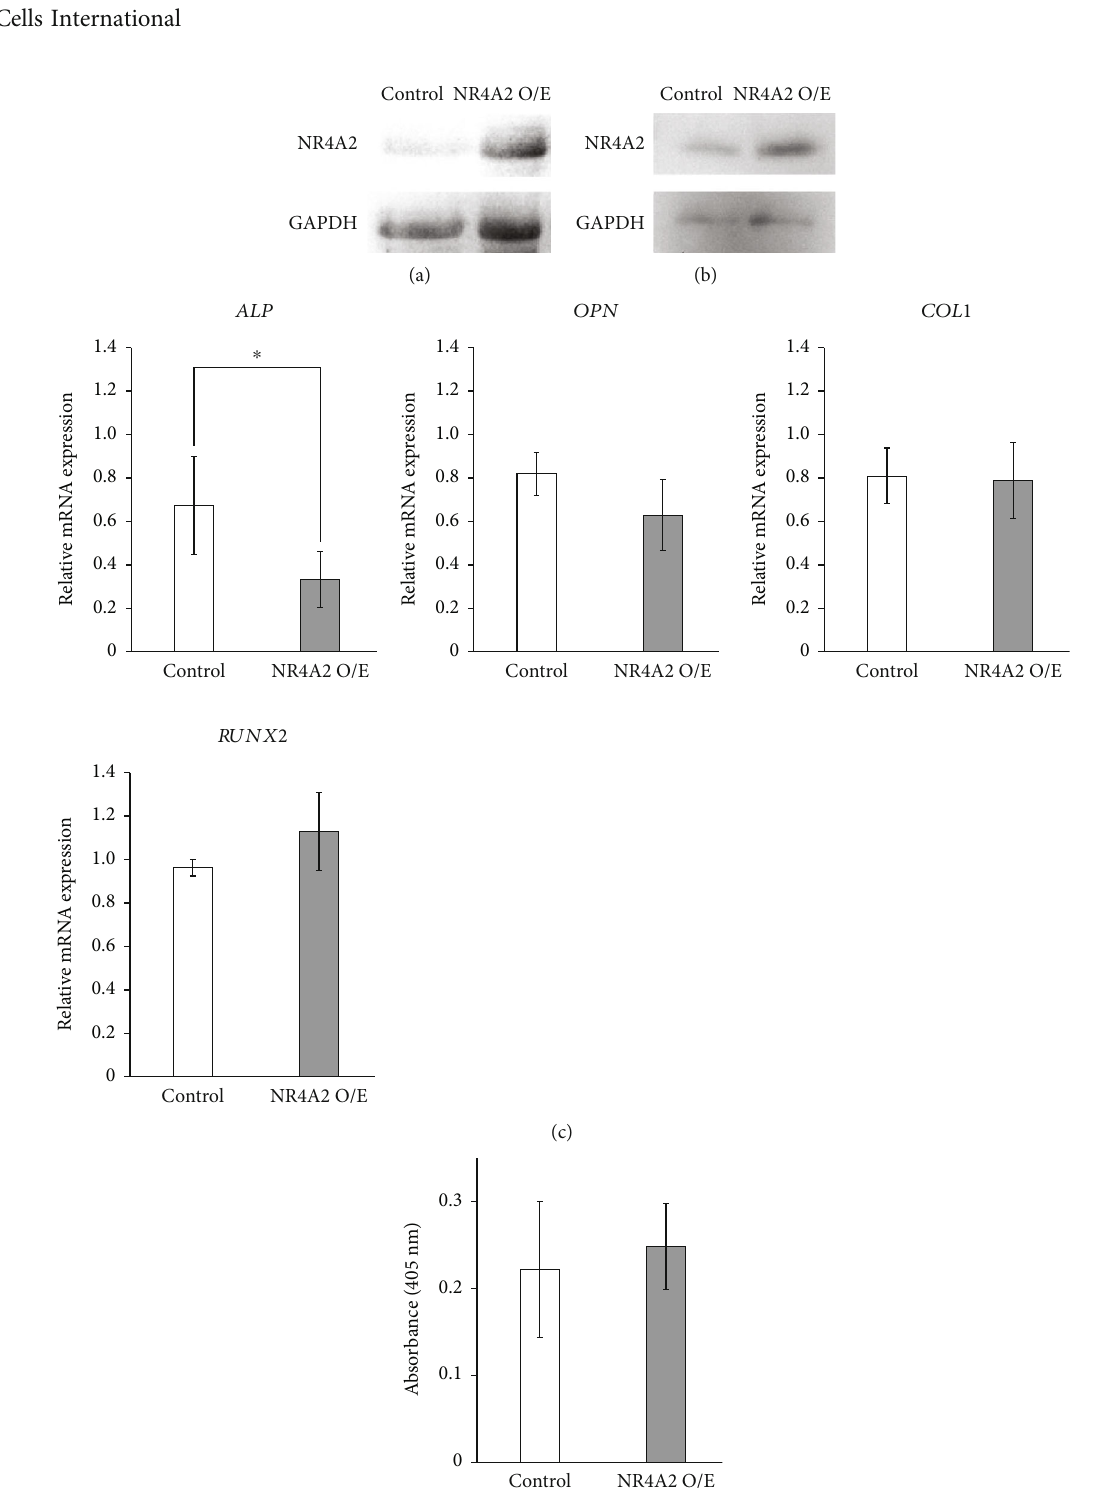
Figure 5: E ff ects of NR4A2 overexpression on osteogenesis in hPDLMSC spheroids. (a, b) Con fi rmation of overexpression of NR4A2 in spheroid-cultured hPDLMSC. Transfection of NR4A2 overexpression vector increased NR4A2 protein expression in monolayer and spheroid-cultured hPDLMSCs. (c) E ff ects of NR4A2 overexpression on ALP, OPN, Col1, and RUNX2 mRNA expression in spheroid hPDLMSCs cultured with OIM. On day 7, the expression of ALP, OPN, Col1, and RUNX2 mRNA was examined by real-time RT-PCR. ∗ p < 0 : 05 (compared with control). (d) E ff ects of NR4A2 overexpression on ALP activity in spheroid-cultured hPDLMSCs cultured with OIM. On day 7, ALP activity was measured. ∗ p < 0 : 05 (compared with control). All experiments were performed with samples from four